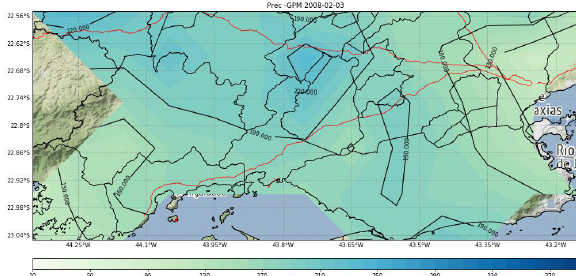
Figure 3. Accumulated daily rainfall shown as shaded and black contour lines with red lines representing pipeline transmissions.